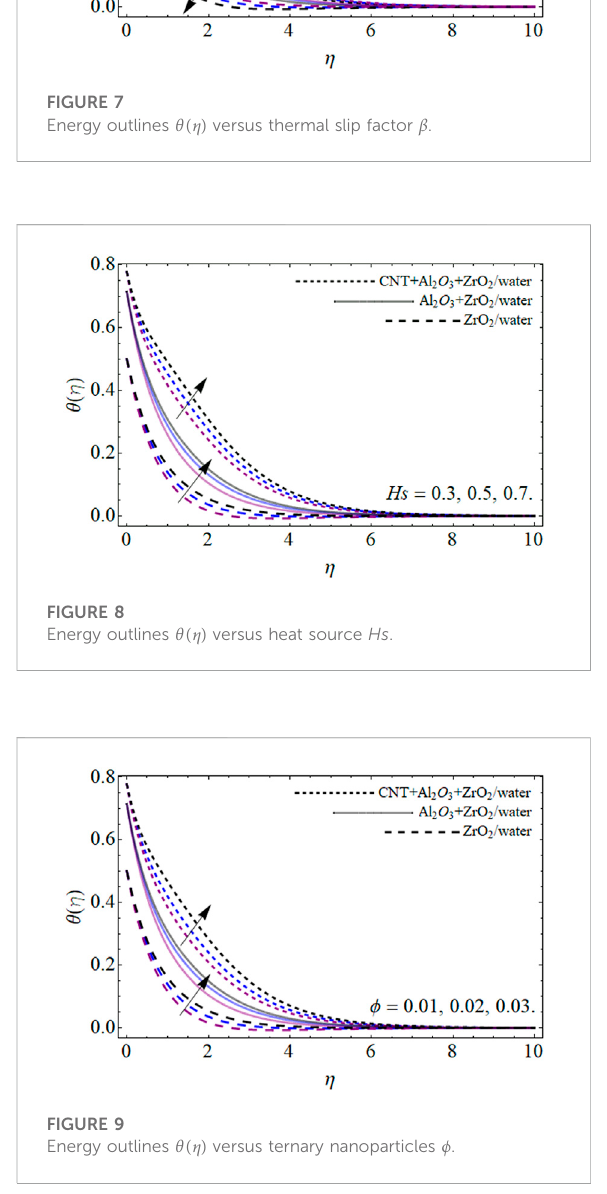
Step 3: Apply Cauchy principal and discretized Eqs 24 – 27. After discretization, the obtained set of equations is